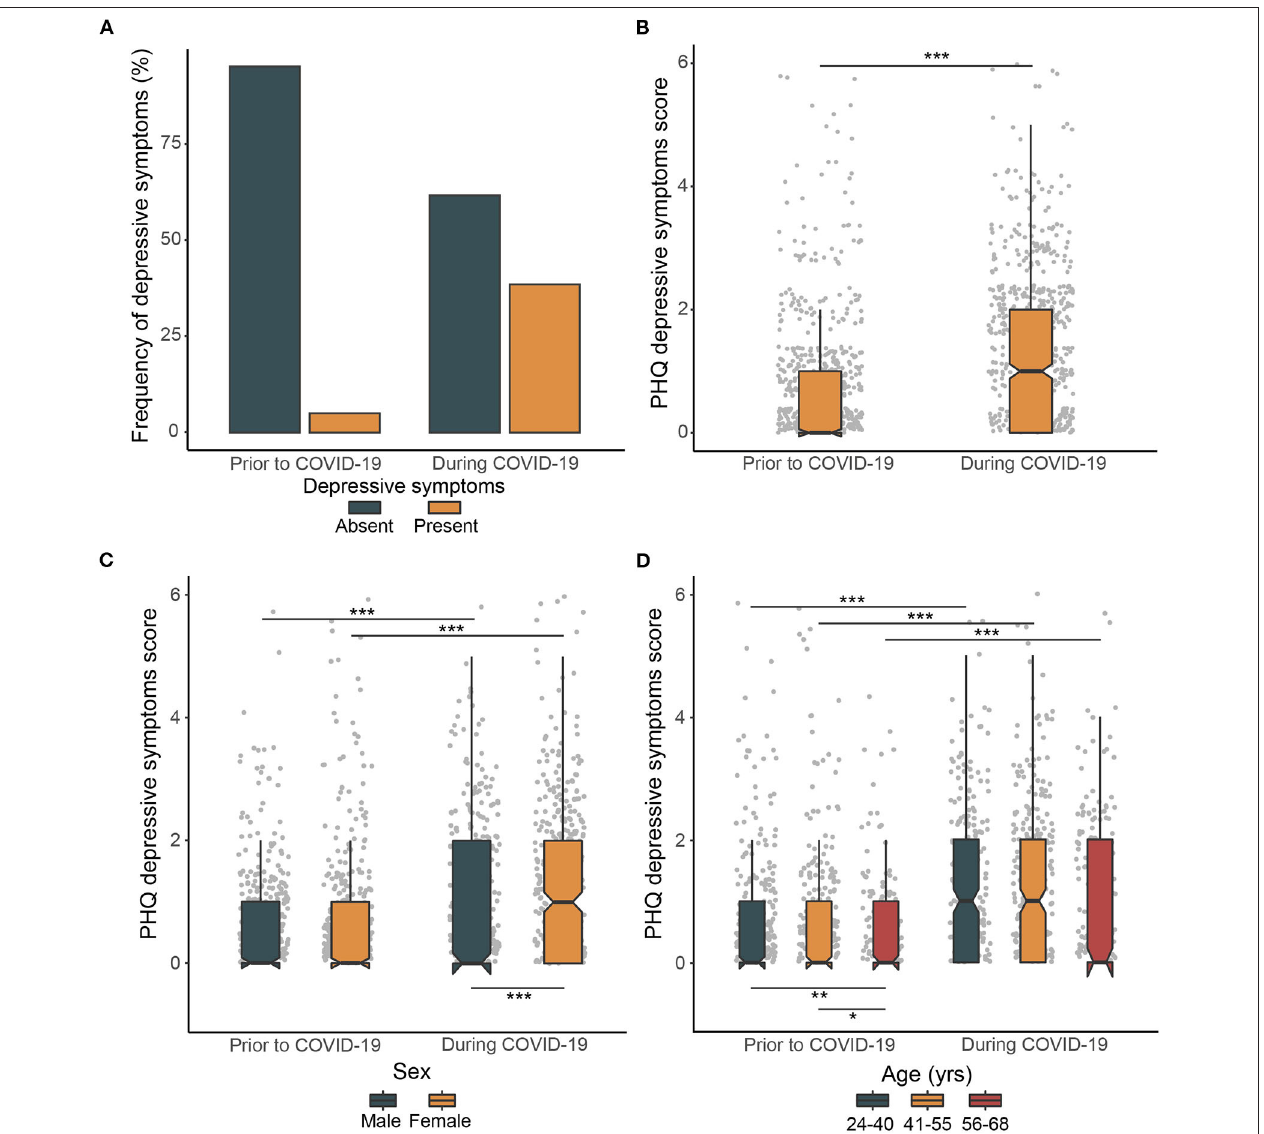
FIGURE 2 | Prevalence of severity of depressive symptoms prior to and during COVID-19 lockdown. (A) Frequency of depressive symptoms prior to and during COVID-19 lockdown. (B) Changes in the PHQ depressive symptoms score prior to and during COVID-19. (C) Sex differences in changes in the severity of depressive symptoms prior to and during COVID-19. (D) Age group differences in changes in the severity of depressive symptoms prior to and during COVID-19. The box plots with whiskers represent the median and the first and the third quartiles are extended by 1.5 times the interquartile range. Upper horizontal bars indicate significant differences in severity of depressive symptoms prior to and during COVID-19, lower horizontal bars indicate significant cross-sectional differences in severity of depressive symptoms between individual groups (* P < 0.05, ** P < 0.01, *** P <